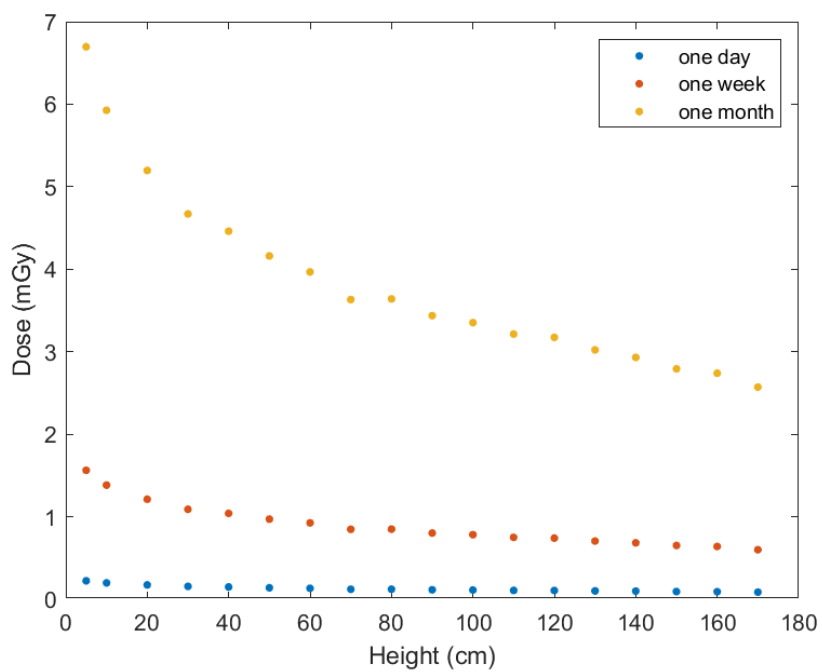
Figure 4. Cell–target absorbed dose of the water phantom at various values of height from the ground surface, induced by the 137 Cs ionizing radiation of 3700 kBq/m 2 for the exposure time of one day, one week and a month, using MCNP6.1 simulations.